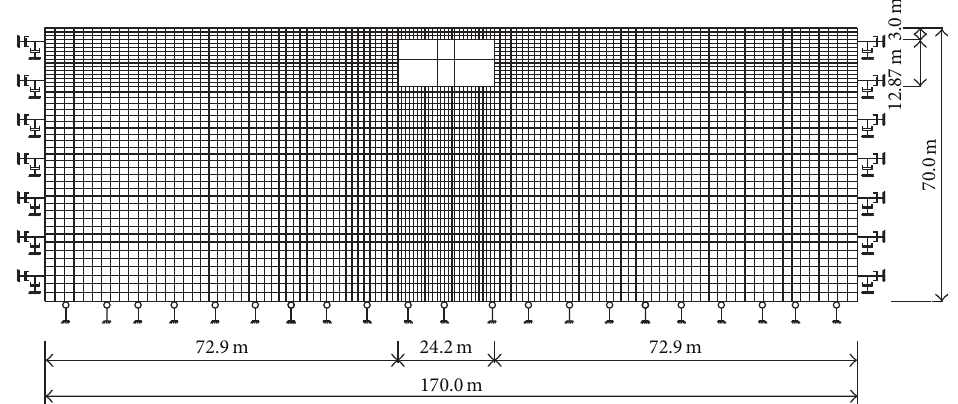
Figure 7: The scope of the calculation area and the mesh generation map.